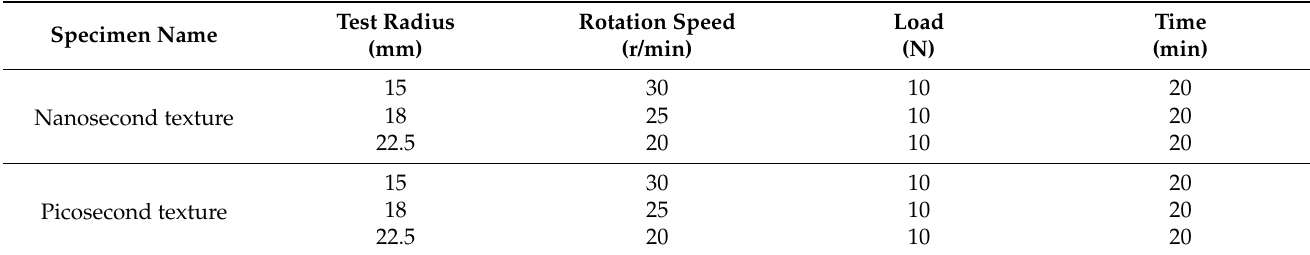
Table 4. Experimental conditions for rotation test.